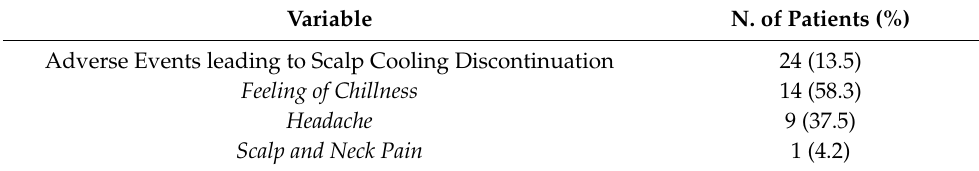
Table 5. Cont. Variable N. of Patients (%) Adverse Events leading to Scalp Cooling Discontinuation Feeling of